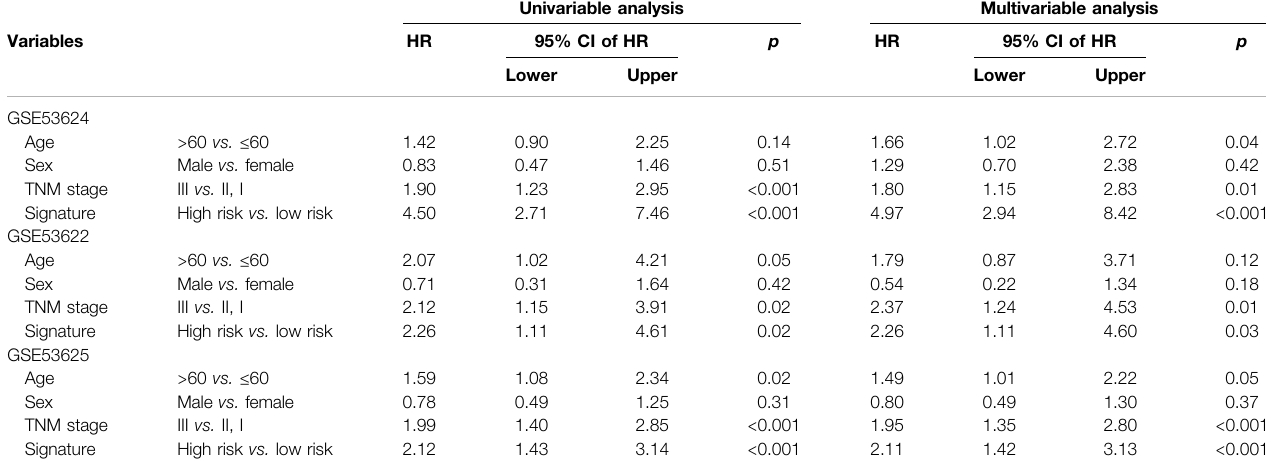
TABLE 3 | Cox regression analysis of the signature with ESCC